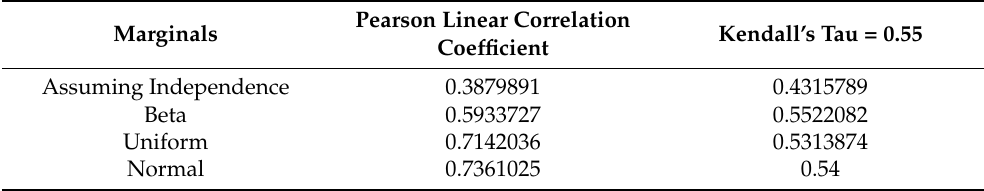
Table 5. Correlation structure of the bivariate pair HIVAIDS and non-HIVAIDS for females.